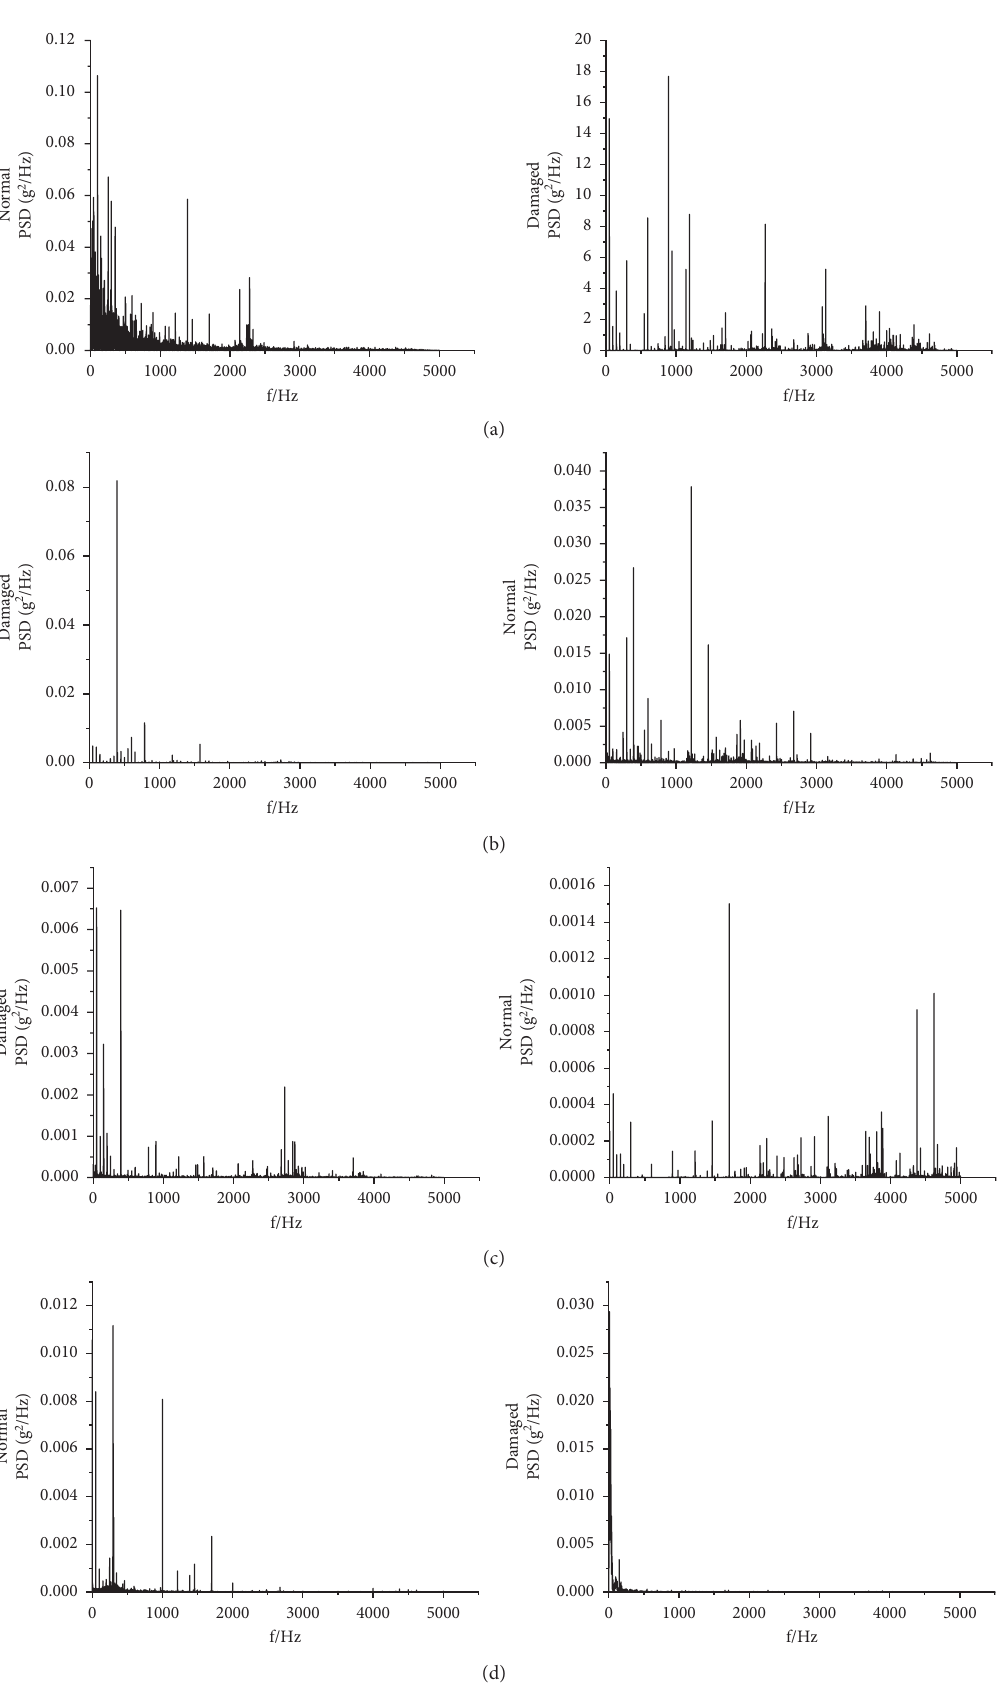
Figure 5: Vibration power spectrum. (a) Base direction power spectrum of vibration signal. (b) Radial direction power spectrum of vibration signal. (c) Vertical direction power spectrum of vibration signal. (d) Axial direction power spectrum of vibration